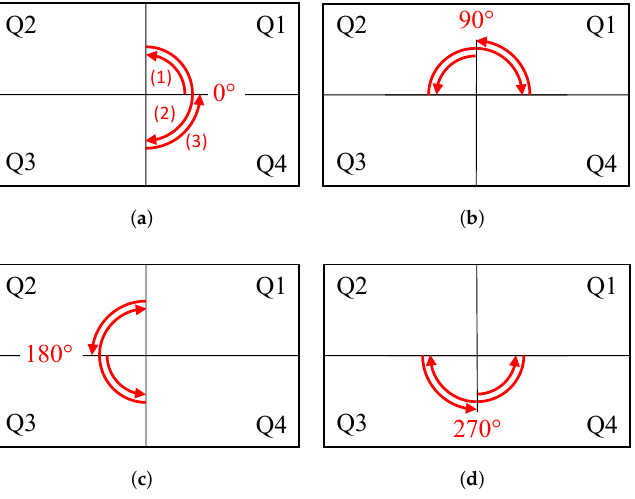
Figure 6. Definition of full-swivel chair rotational movement pattern in terms of initial azimuthal angle and covered quadrants: ( a ) φ 0 = 0 ◦ covering Q1 and Q4, ( b ) φ 0 = 90 ◦ covering Q2 and Q1, ( c ) φ 0 = 180 ◦ covering Q3 and Q2, ( d ) φ 0 = 270 ◦ covering Q4 and